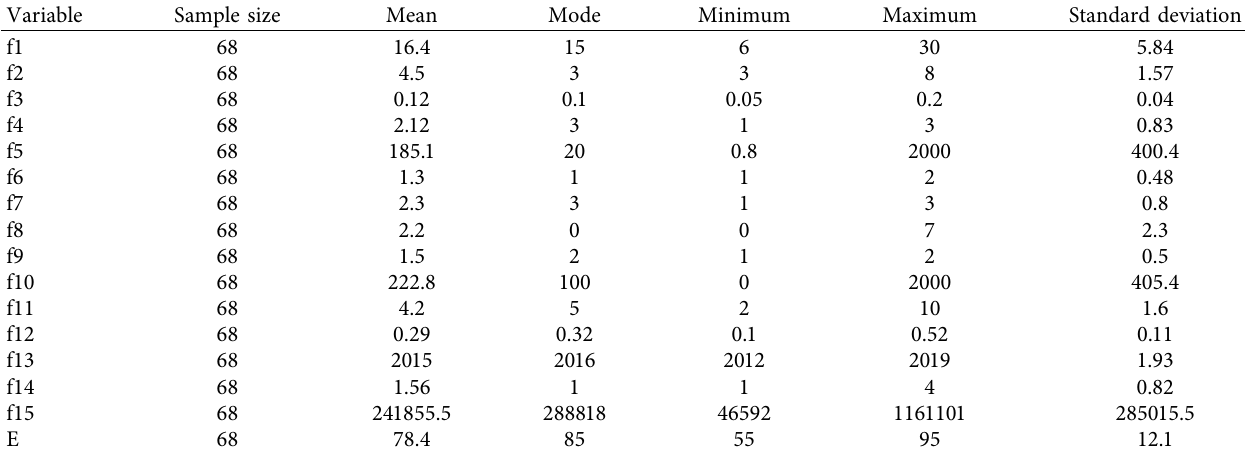
Table 3: Descriptive statistics of